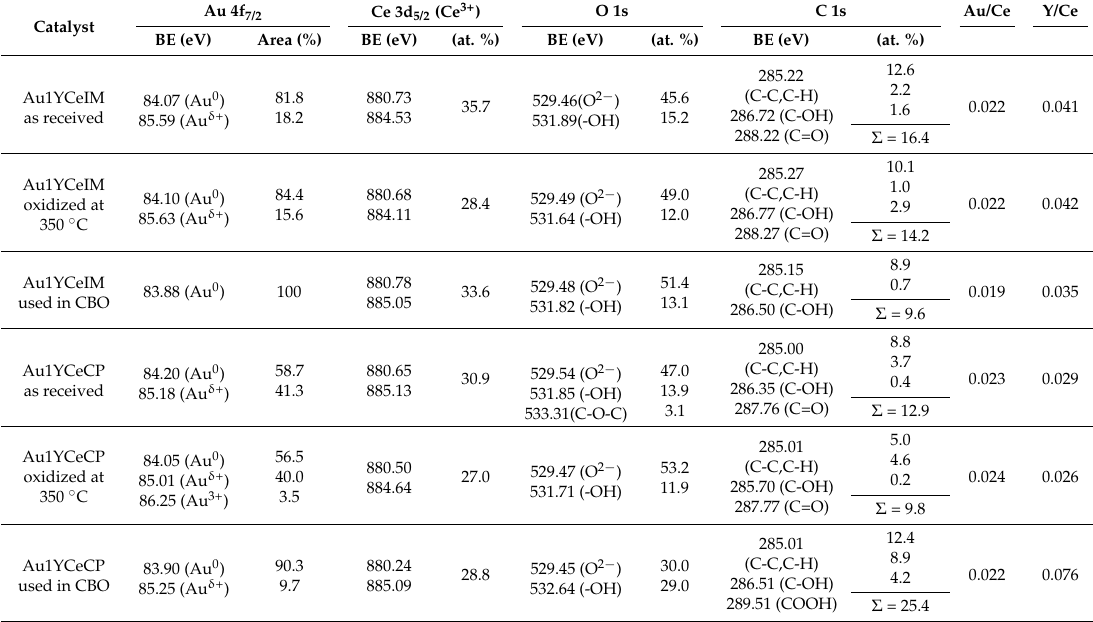
Table 3. XPS data of the studied